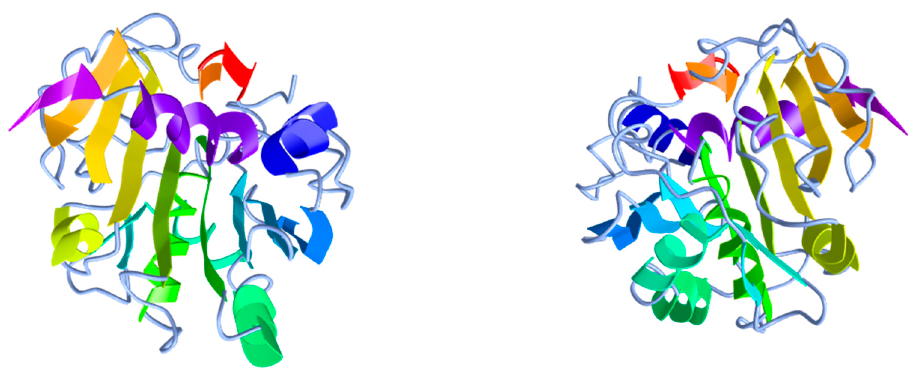
Figure 5. Three-dimensional structure of R. delemar ( = oryzae ) lipase from two di ff erent points of view. PDB ID: 1TIC. Image obtained from iCn3D web-based 3D structure